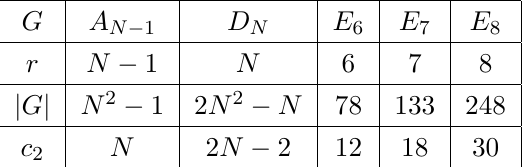
Table 1 . Data on simply laced Lie